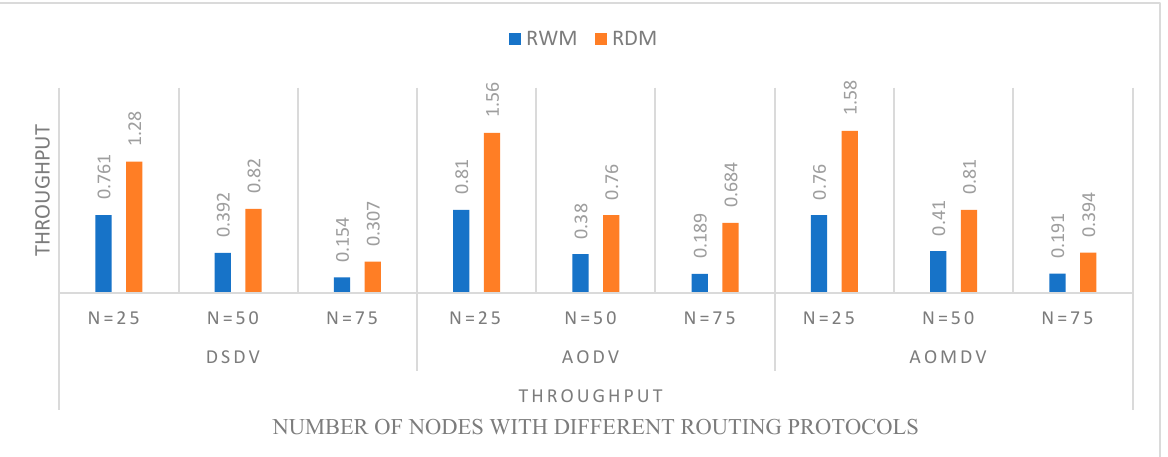
Figure 6. Performance analysis of RWM and RDM on various routing protocols in terms of through- put .